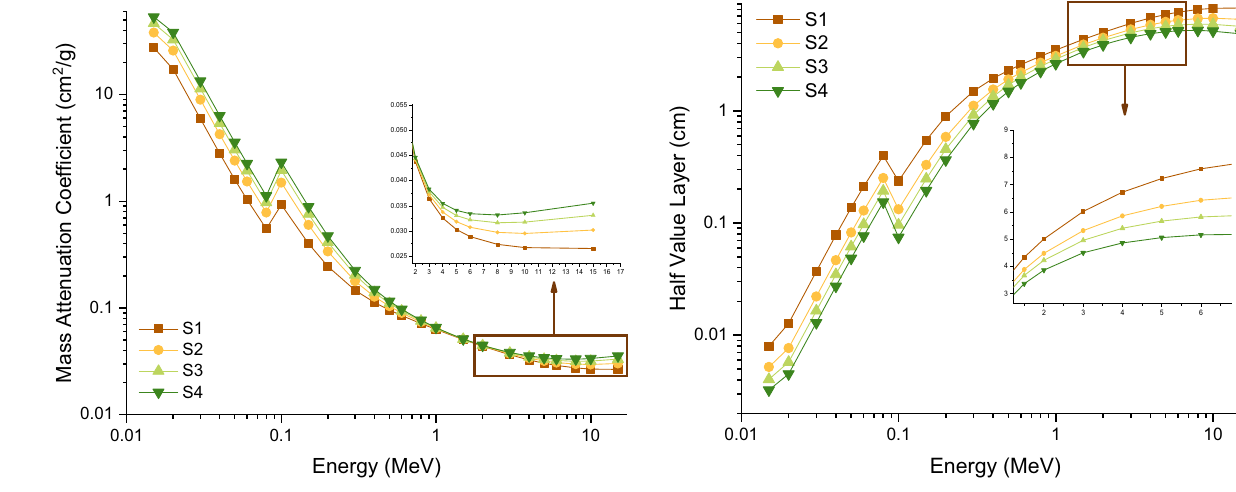
Figure 8: Variation of HCL ( cm ) with photon energy ( MeV ) for all S1 – S4